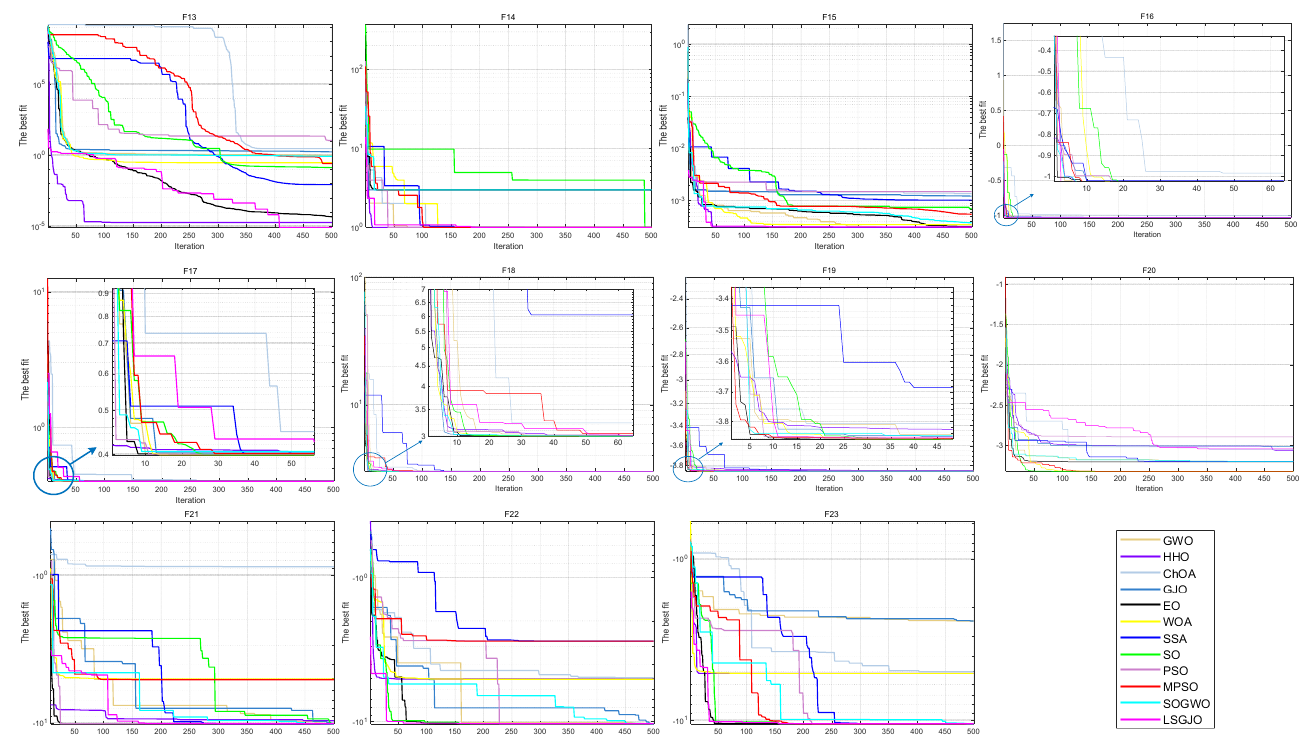
Figure 4. The convergence curves of the LSGJO and other comparison algorithms with Dim = 30.